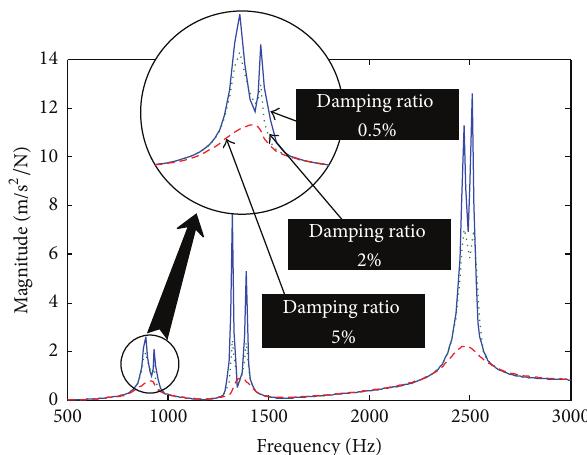
Figure 15: Gyroscopic moment effect of shaft on direct FRF H 𝑦𝑦 at front tip. Rotational velocity: 10000 rpm.